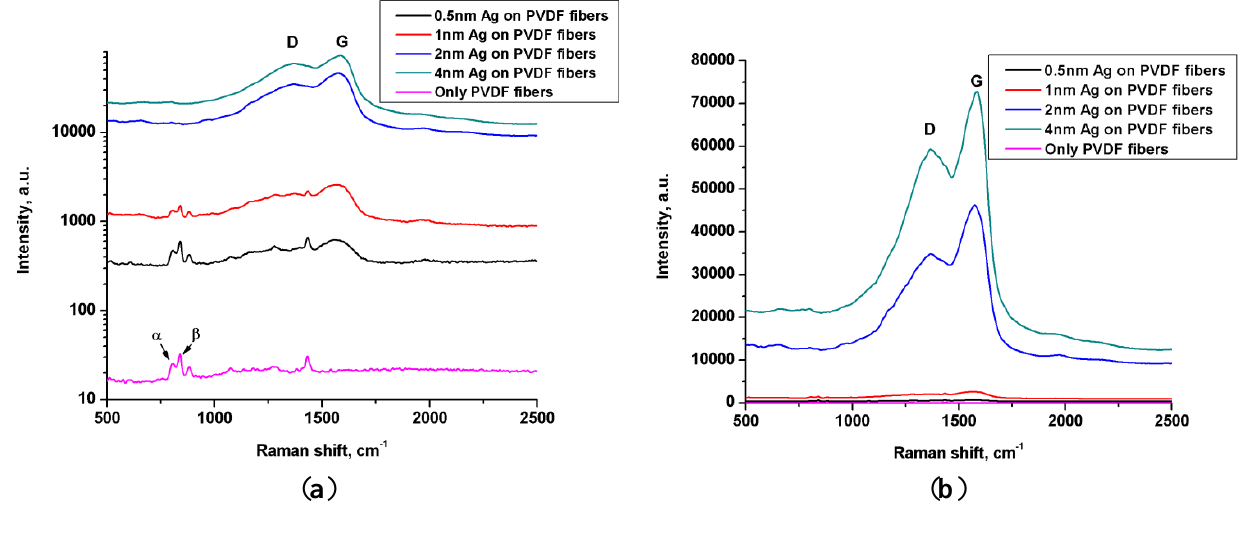
Figure 4. ( a ) Raman spectrum of “PVDF fiber-silver NPs” composite with different silver layer thickness (0.5 to 4 nm); ( b ) Same data as in ( a ), but plotted on “linear” scale to highlight the presence of D and G